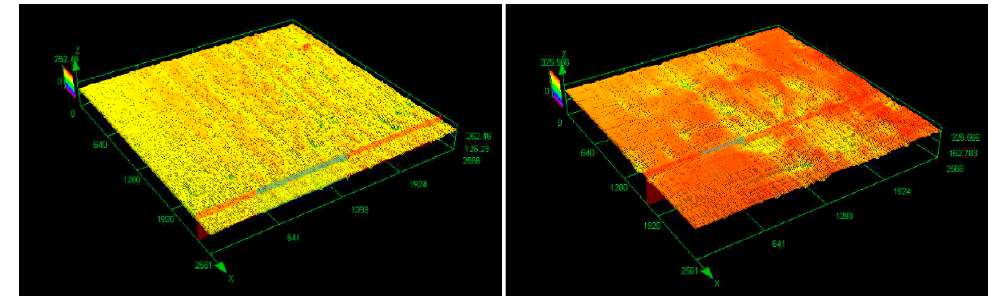
Figure 5. 3D image of alder wood surface before ( left ) and after 2 years of weathering ( right )—confocal laser scanning microscopy (area of 800 × 800 μ m). Forests 2018 , 9 , x FOR PEER REVIEW